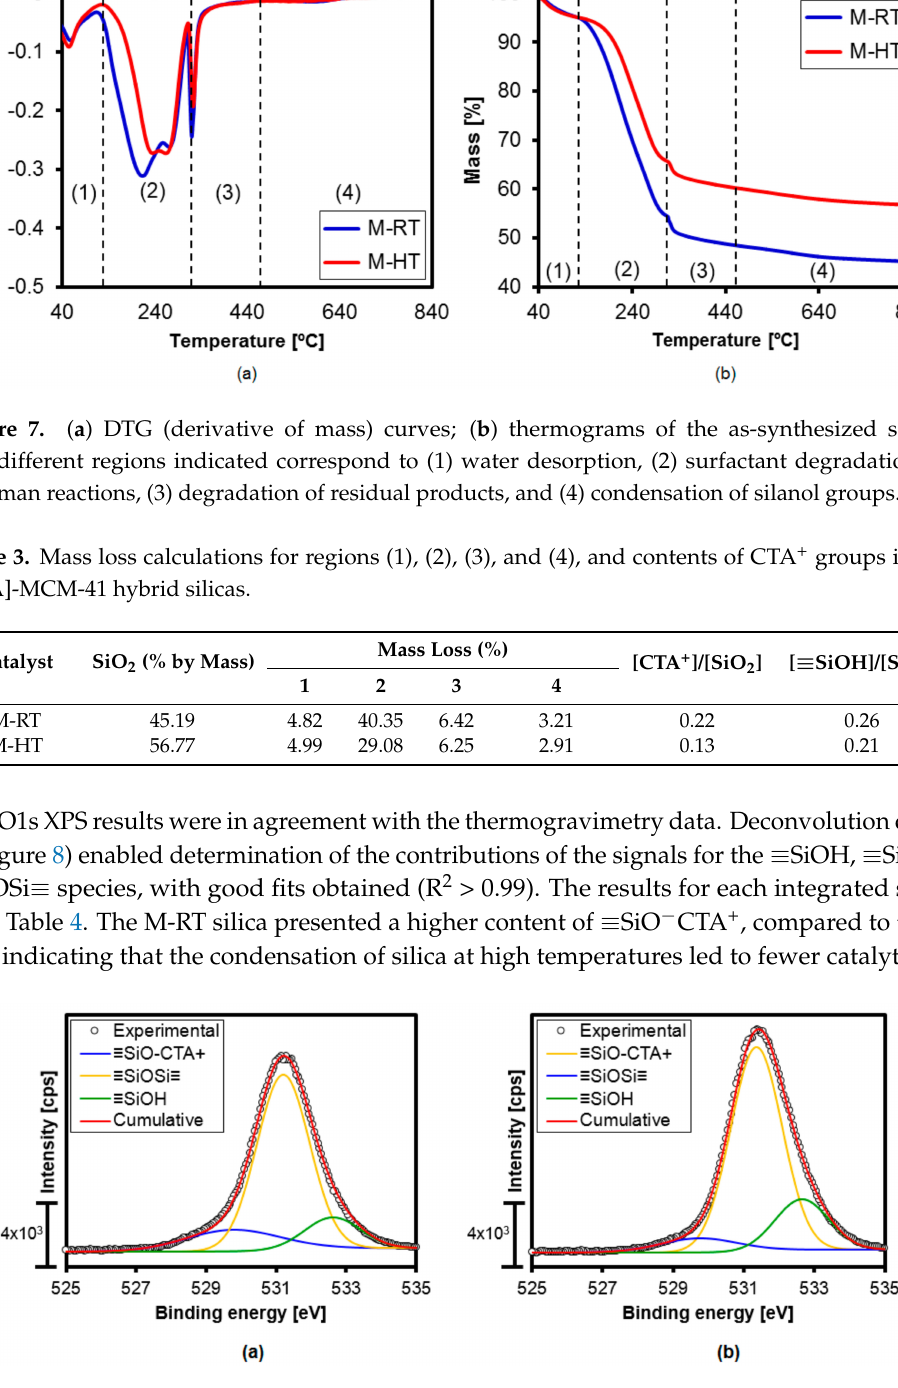
Figure 8. O1s XPS spectra of the hybrid silicas M-RT ( a ) and M-HT ( b ), and deconvolution of the signals. Table 4. Contributions of O1s species in the XPS signals of the hybrid